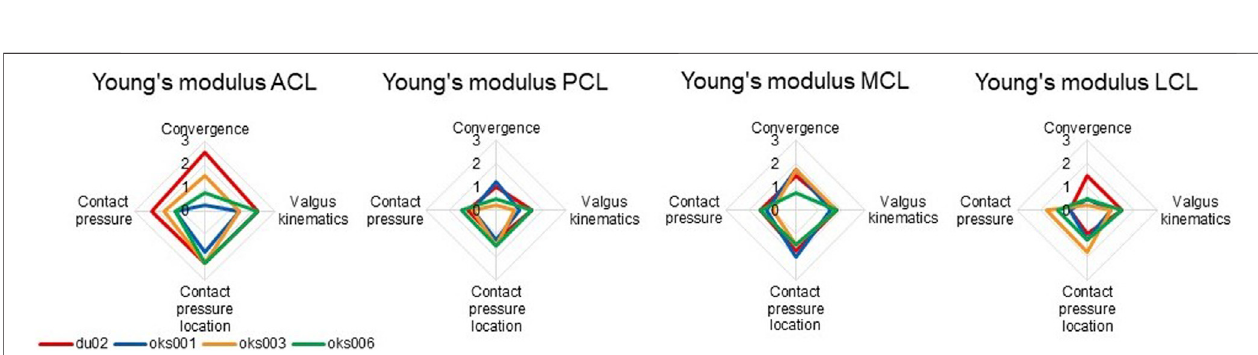
FIGURE 7 | Ligament Young ’ s modulus sensitivity analysis simulation results rated on in fl uence on convergence, valgus kinematics, peak contact pressure, and location of peak contact pressure (0 (No in fl uence) to 3 (Large in fl